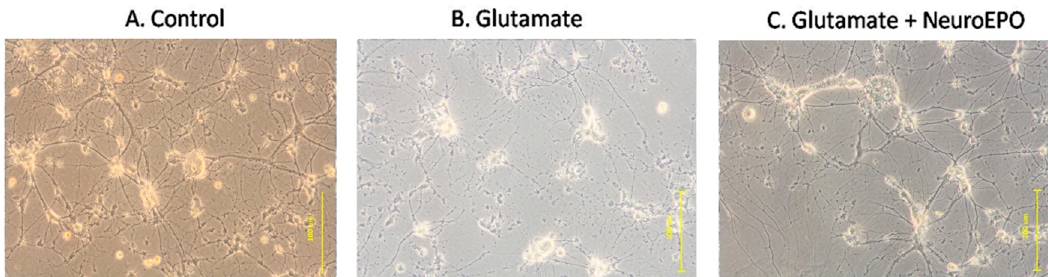
Figure 4. Microscopic observation of primary cortical neurons by phase-contrast microscopy. ( A ) Photomicrographs of cortical neurons after nine days, maintained with Neurobasal medium, show the presence of large cells with thick and thin processes that make contact with the neighbouring cells. ( B ) Photomicrographs of cortical neurons exposed to 100 µM glutamate for 15 min, followed by 24 h in Neurobasal medium. Small cells, retracted with thin processes that do not make contact with neighbouring cells can be observed. ( C ) Photomicrographs of cortical neurons exposed to 100 µM glutamate for 15 min followed by 24 h in Neurobasal medium containing 100 ng/mL of neuroEPO. Cells have thick processes and preserve contact with neighbouring cells. 100× magnification.